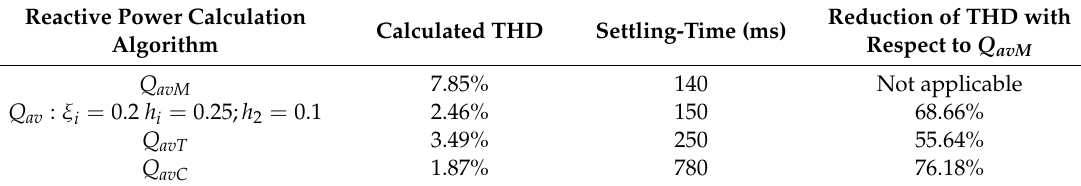
Table 5. Settling-time and THD for the simulation of reactive power algorithms.